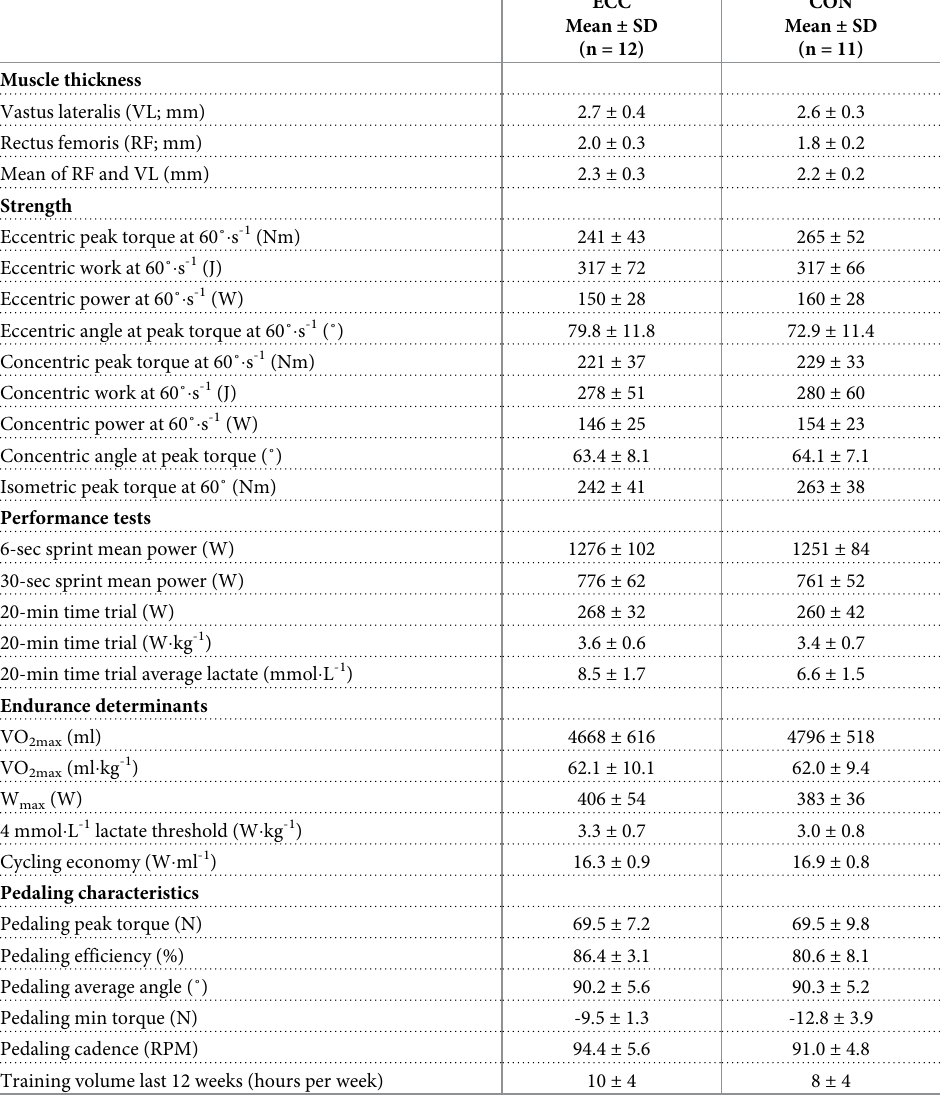
CON: Concentric cycling; ECC: Eccentric cycling; RPM: Revolutions per